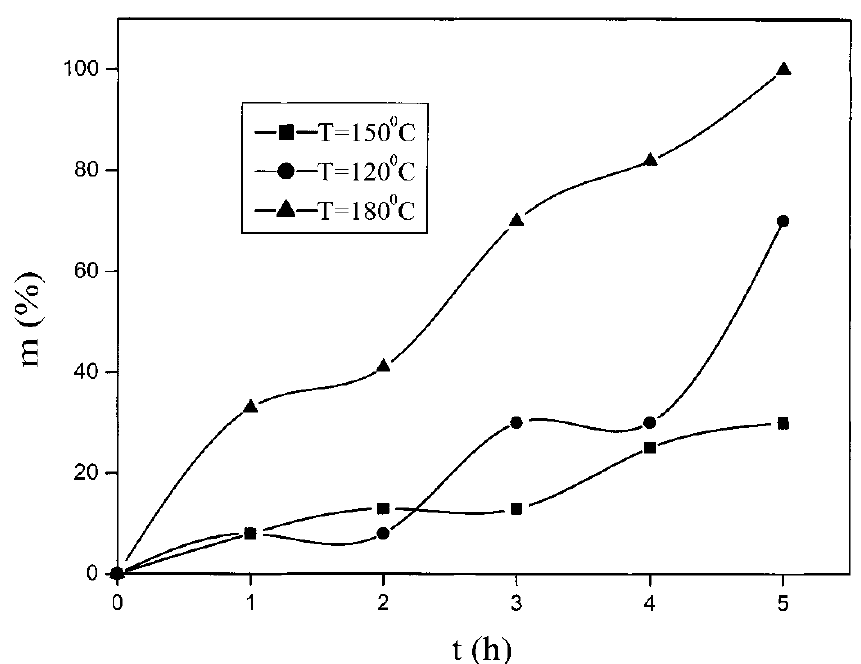
FIGURE 3 Dependence of m on t under the pressurised vapour